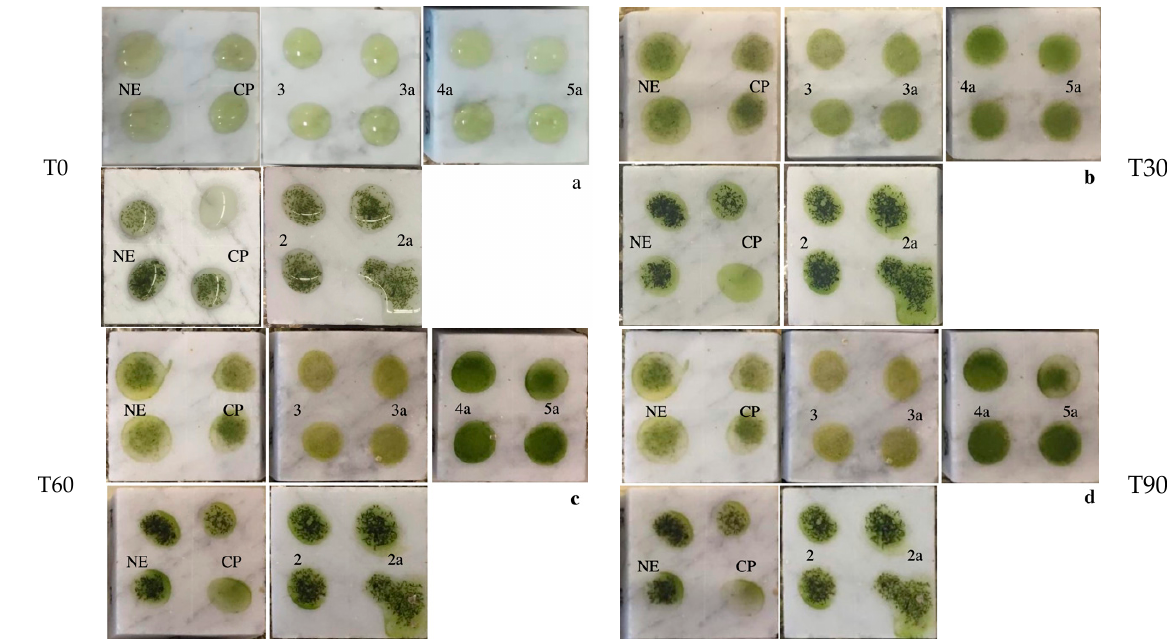
Figure 7. Untreated (CP) and treated marble probes’ behavior toward the microbial colonization under laboratory conditions. ( a ) Immediately after inoculation, T0; ( b ) after 30 days of incubation under constant illumination, T30; ( c ) after 60 days of incubation under constant illumination, T60; and ( d ) at the end of the experiment (90 days of incubation under constant illumination), T90.